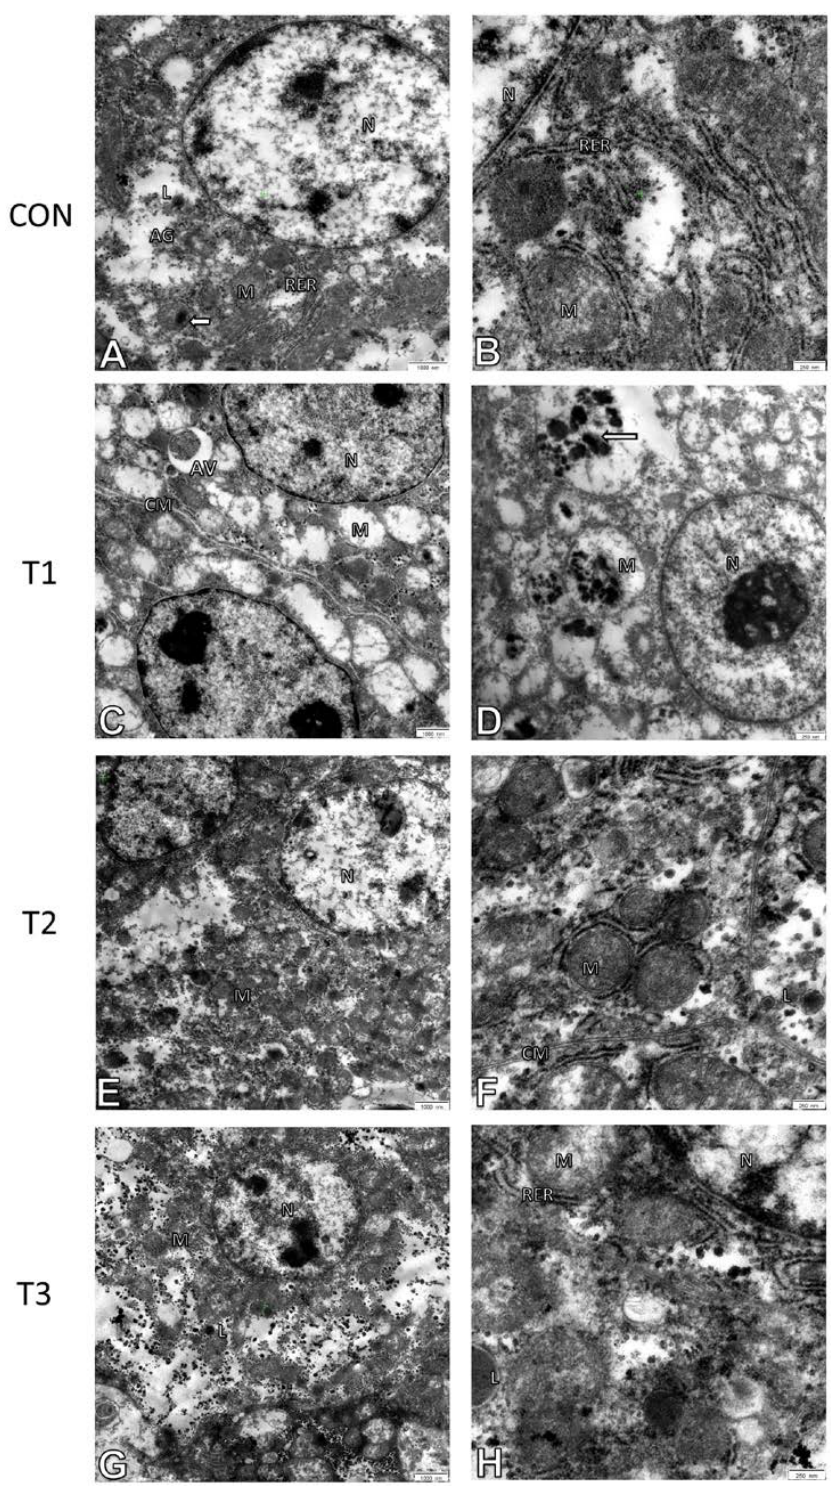
Figure 4. Ultrastructure of representative hepatocytes of cockerels: CON—control group ( A , B ), T1—diet with upper dose of inorganic Se ( C , D ), T2—diet with upper dose of Se in the organic form ( E , F ), T3—diet with upper dose of Se in the form of nanoparticles ( G , H ). Scale bar 1000 nm ( A , C , E , G ) and 250 nm ( B , D , F , H ). N—nucleus; M—mitochondria; RER—rough endoplasmic reticu- lum; L—lysosomes; AV—autophagic vacuole; CM—cell membrane; arrow—electron dense deposits in